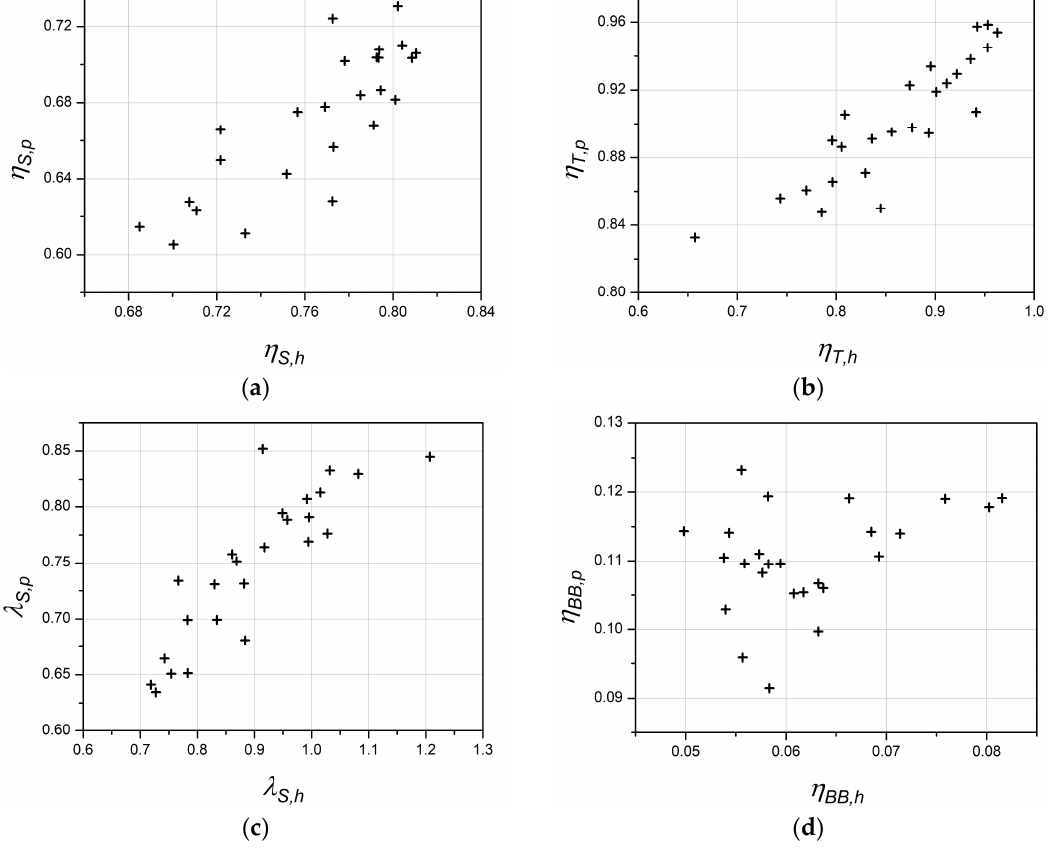
Figure 12. Comparison between the high load results and the partial load results. ( a ) Scavenging efficiency; ( b ) trapping efficiency; ( c ) delivery ratio; ( d ) evaluation objective function.